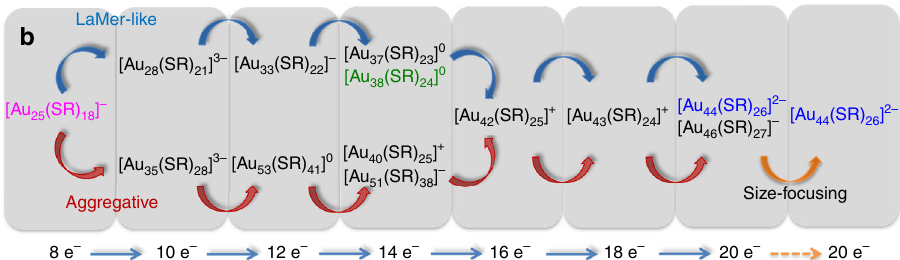
Fig. 5 Schematic illustration of size growth reaction from [Au 25 (SR) 18 ] − to [Au 44 (SR) 26 ] 2 − . a Schematic energy diagram of [Au n (SR) m ] q and CO-associated [Au n (SR) m ] q species. E a,Au(I)-SR and E a,Au25 denotes the formation energy of [Au n (SR) n CO] 0 and [Au 25 (SR) 18 CO] − , respectively; the relative energies are schematically drawn according to the stability of [Au n (SR) m ] q species in CO-saturated solution; the dotted curves indicate non-elementary reaction pathways. b Growth pathways from [Au 25 (SR) 18 ] − to [Au 44 (SR) 26 ] 2 −